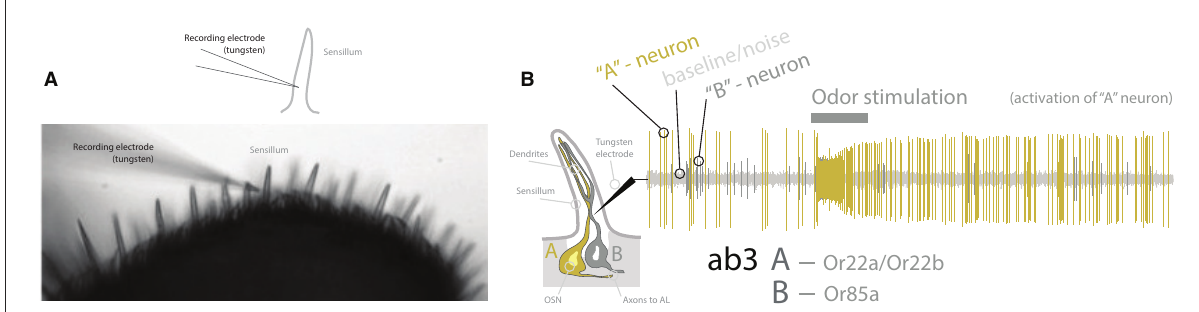
FIGURE3 Methodology for recording from OSNs. (A) Drawn schematic and microscope image of recording electrode puncturing inside the shaft of the sensillum. This is the primary method, single sensillum recording (SSR), for Drosophila chemosensory deorphanization, which identifies which odors best activate each OSN and OR expressed at the periphery of the fly. (B) A diagram of the interior of a sensillum [e.g., antennal basiconic three (ab3)], showing two OSNs (“A” and “B”). Recordings provide baseline/noise, as well as large “A” neuron spikes and small “B” neuron spikes. Two amplitudes (e.g., large and small spikes) are indicative of two OSNs. Spikes occur spontaneously pre-stimulation but increase following stimulation with odor/ligand. In this example, only the “A” neuron increases firing; thus, this odor stimulation (e.g., odor/ligand) is activating only this neuron and odorant receptor (OR) type. OR, olfactory receptor; OSN, olfactory sensory neuron; ab3, antennal basiconic three; Or22a, olfactory receptor type 22a; AL, antennal